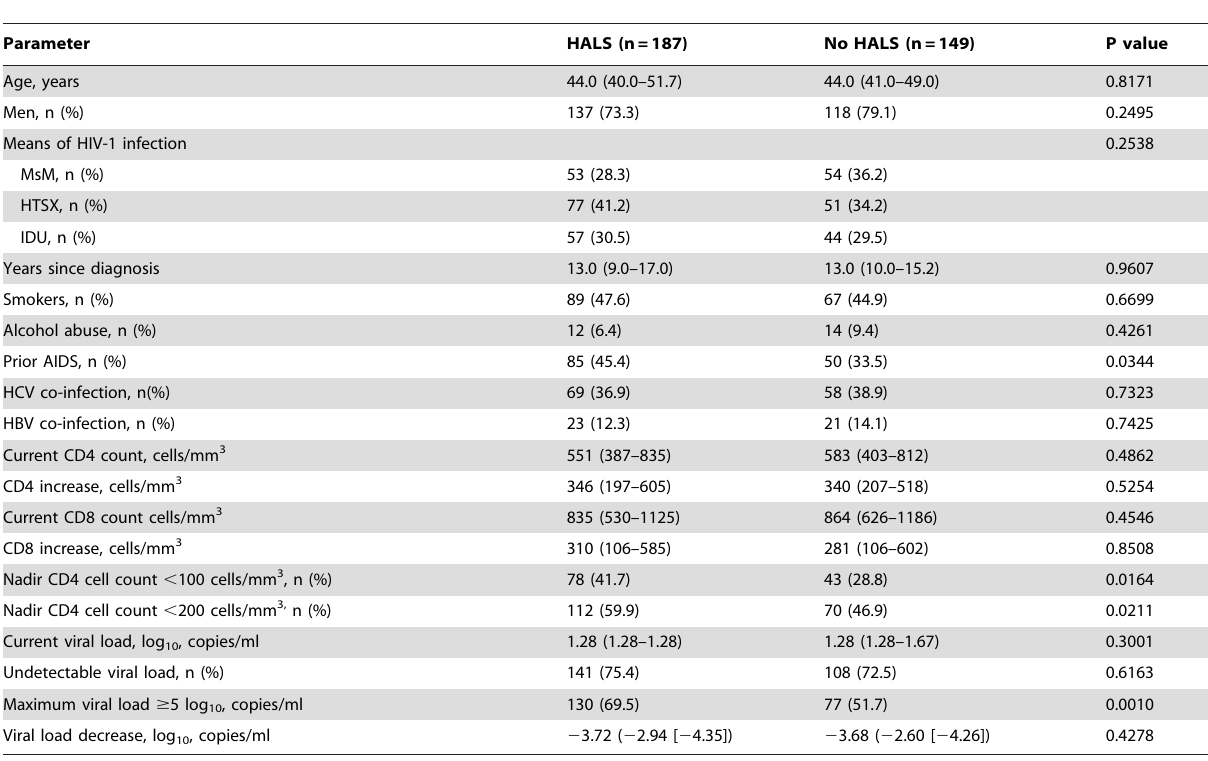
Table 1. Demographics and viro-immunological status of the population studied.